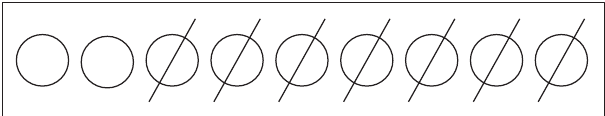
FIGURE 4: Depiction of Derek’s smart-board picture of 9 minus 7.